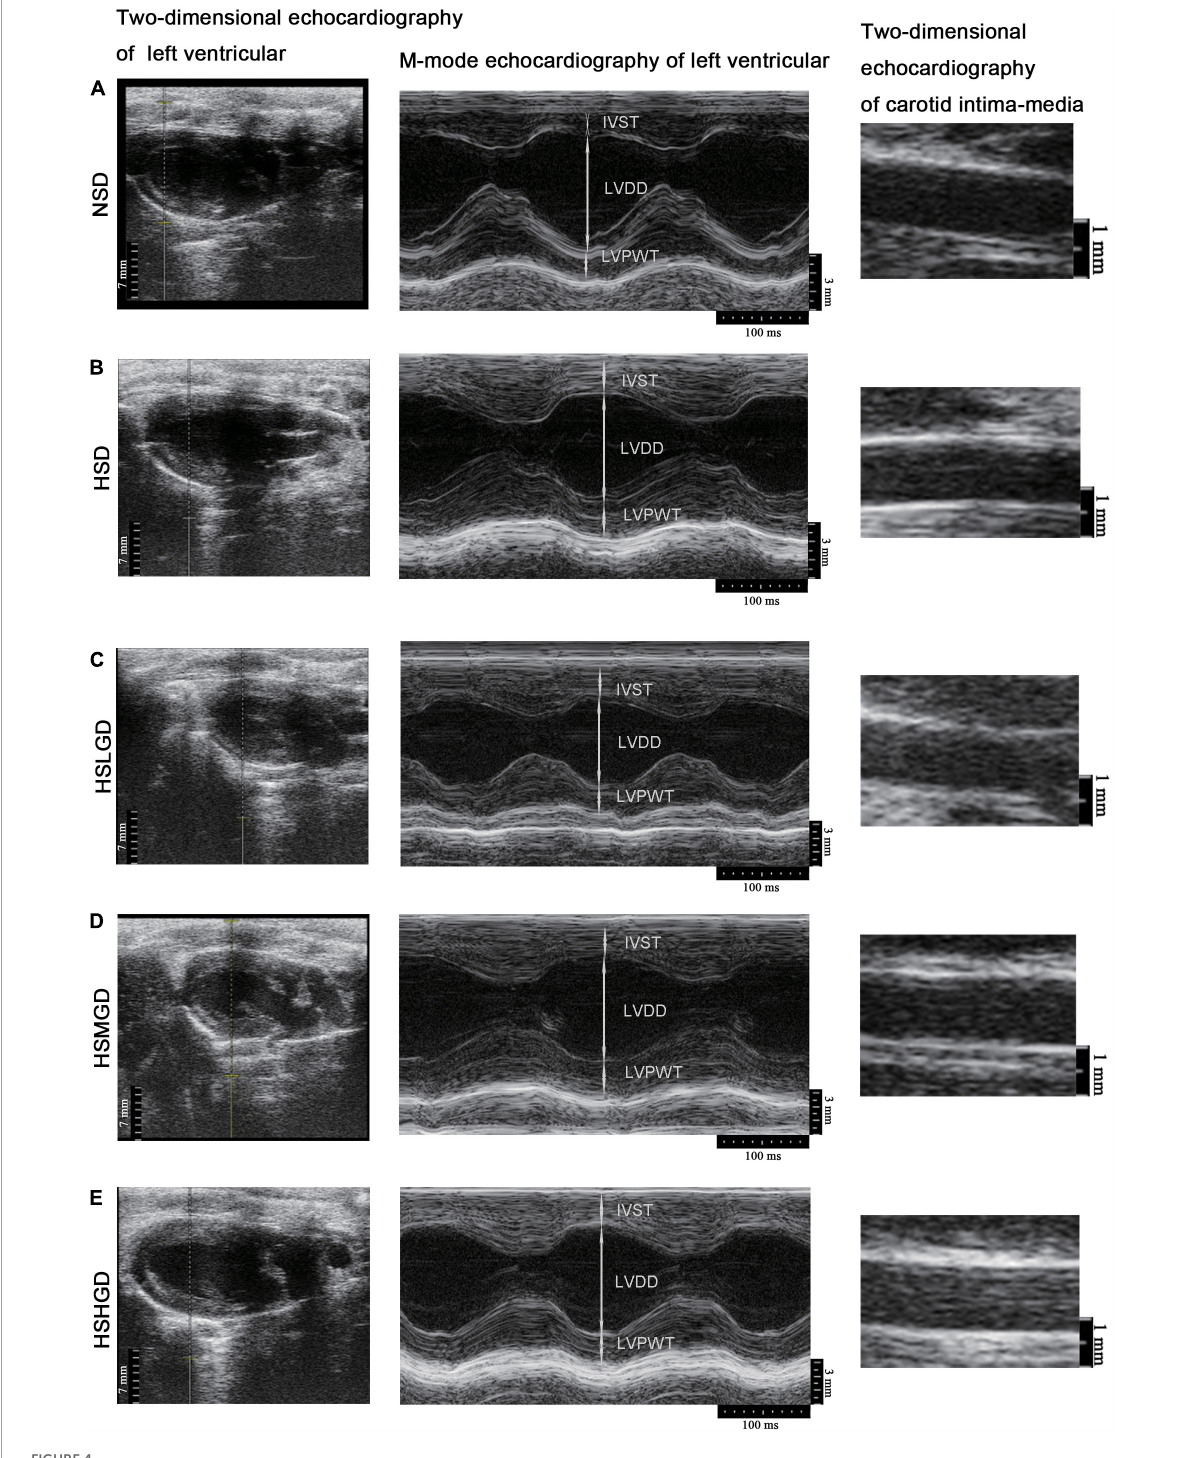
FIGURE4 Representative echocardiography images of carotid arteries and cardiovasculature of rats fed on a normal-salt diet (NSD, A ), high-salt diet (HSD, B ), high-salt + low-dose glutamine diet (HSLGD, C ), high-salt + middle-dose glutamine diet (HSMGD, D ), or high-salt + high-dose glutamine diet (HSHGD, E ) for the 7-week rearing experiment. Scale bars, 7 mm (Two-dimensional echocardiography of left ventricular), 3 mm (M-mode echocardiography of left ventricle), or 1 mm (Two-dimensional echocardiography of carotid intima-media). n = 5 (NSD, HSHGD) or 6 (HSD, HSLGD, HSMGD) rats per